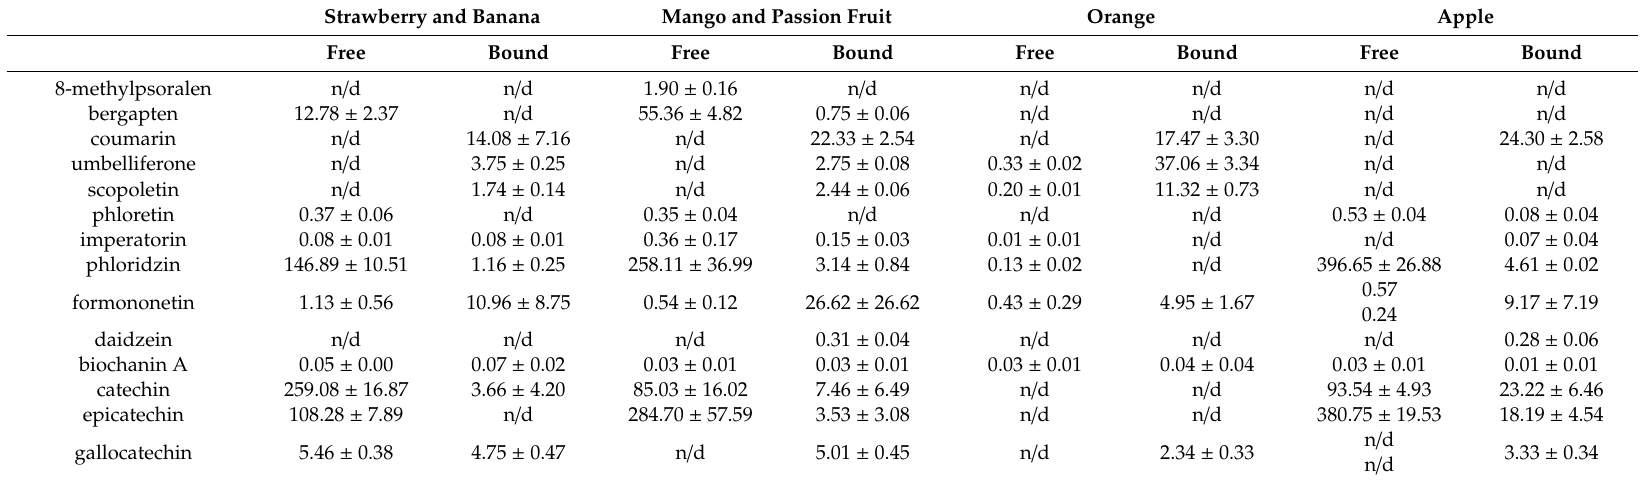
Table 6. Psoralen, coumarin, coumesterol, isoflavone, and catechin content of juice / smoothie